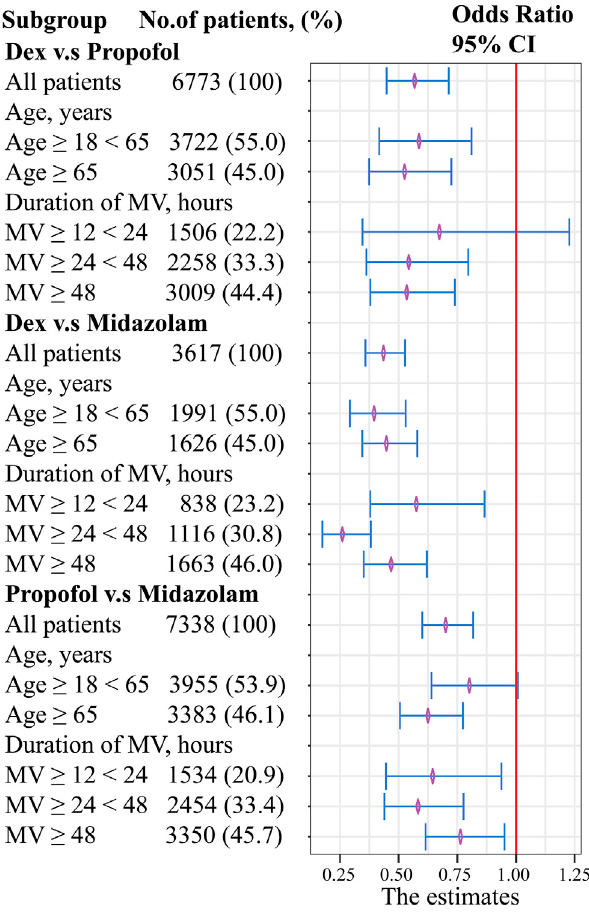
FIGURE1| Forestplotevaluatingtherelationshipbetweenage,duration of mechanical ventilation, and sedatives. Abbreviations: MV, mechanical